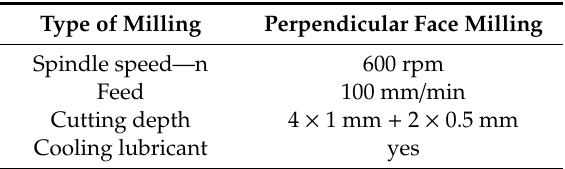
Table 1. Milling parameters.